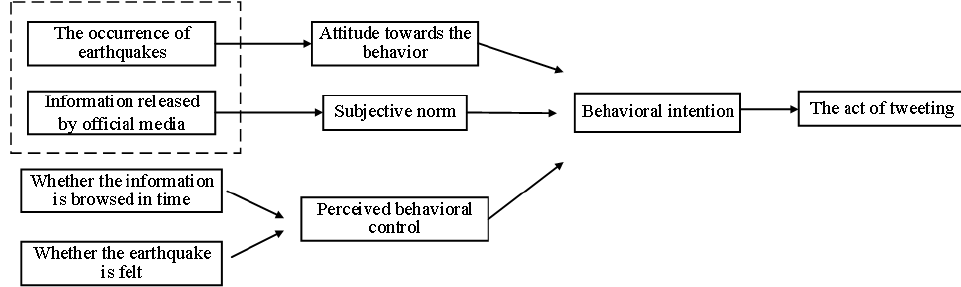
Figure 1. Model of factors that influence people’s behavior.